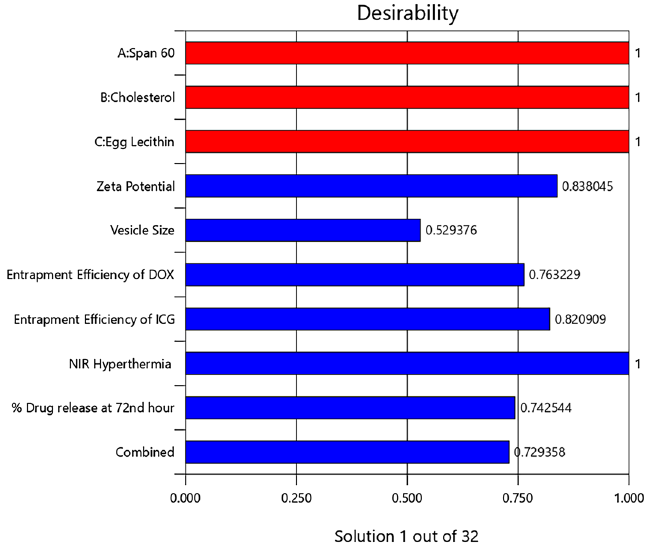
Figure 8. Desirability bar graph for each factor and combination of all responses [Design-Expert version 12.0.5.0].